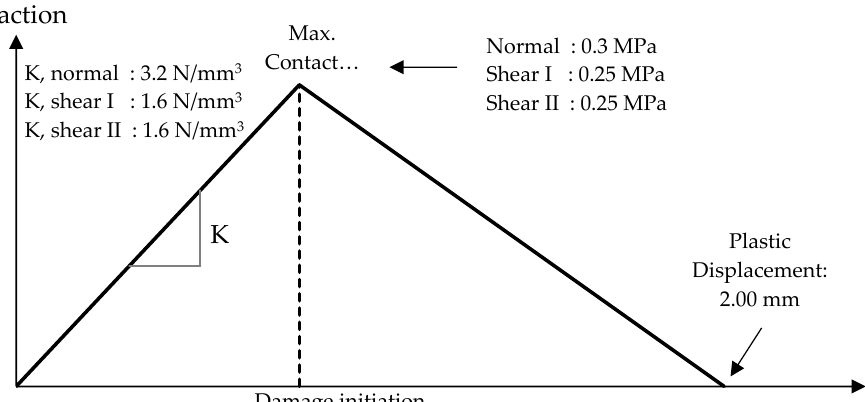
Figure 6. Possible damage types of the cohesive surfaces.